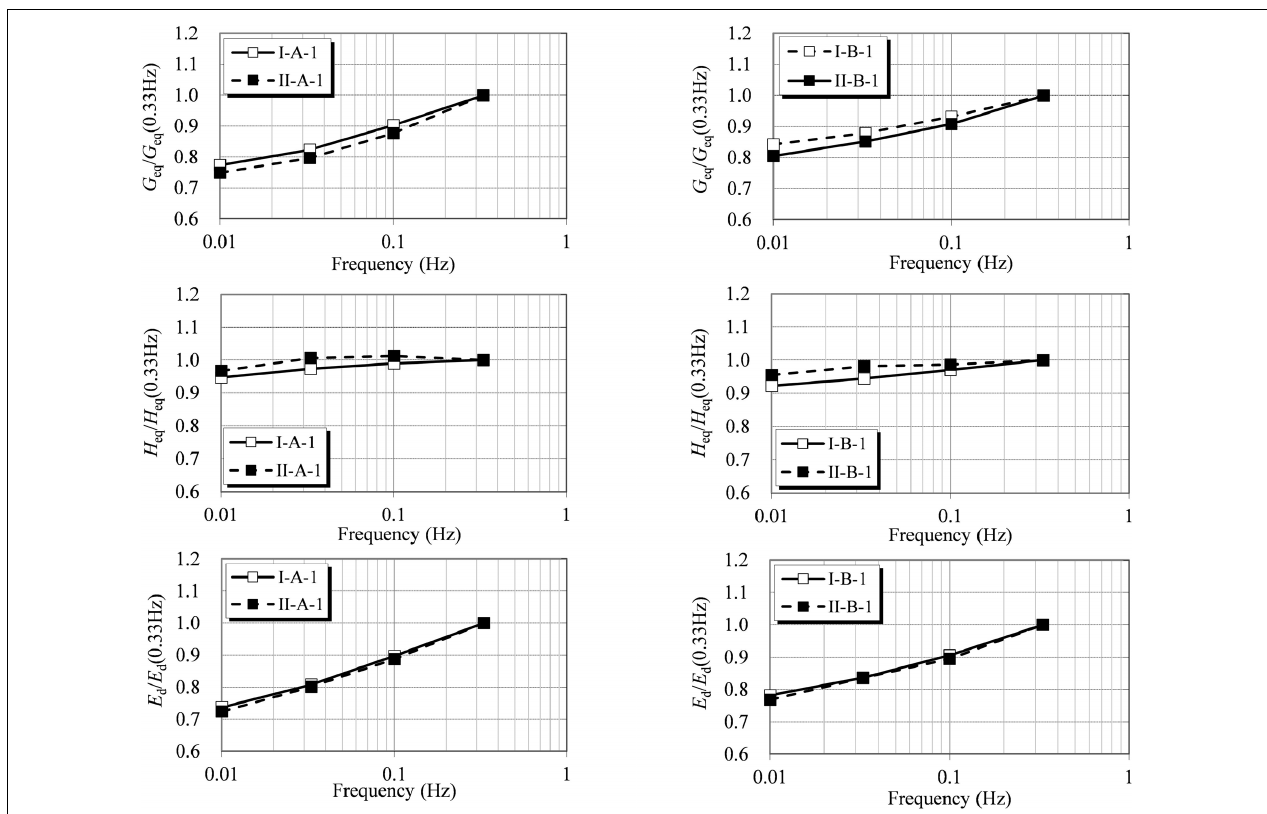
FIGURE 5 | Comparison of shear properties in frequency dependency of-Scale-I and -II at 3rd